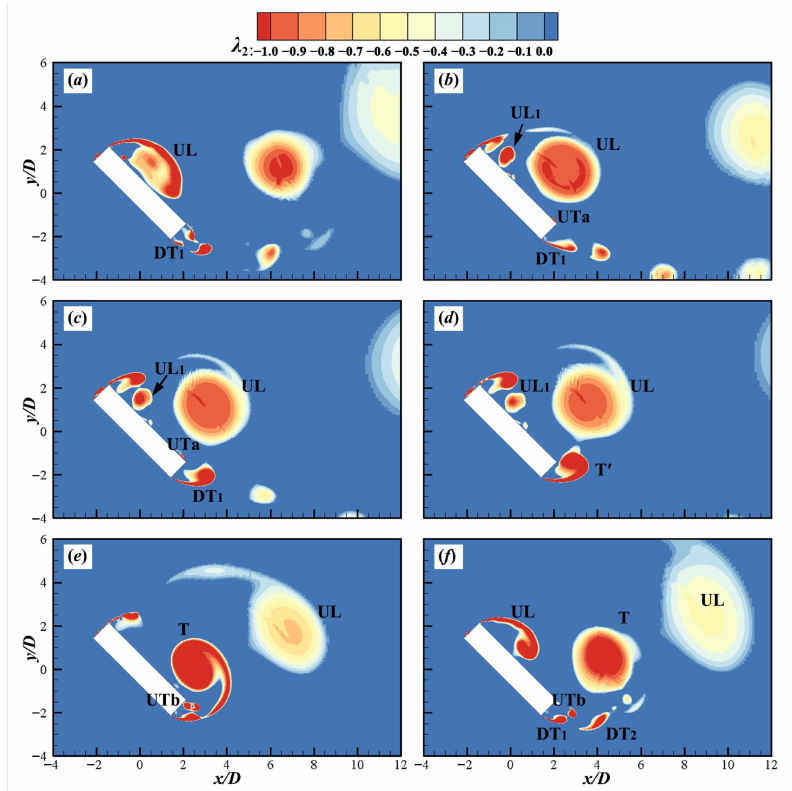
Figure 28. Vortex evolution within a vortex shedding period at α = 45 ◦ . ( a ) tU ∞ /D = 825.7,